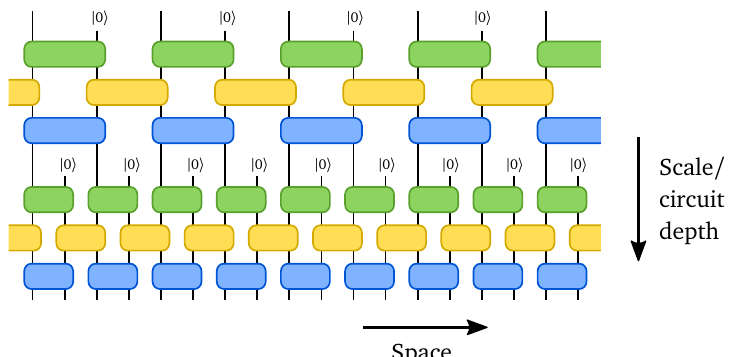
Figure 1: The structure of an entanglement renormalization circuit. Each layer is a constant depth quantum circuit that is supposed to implement a real-space renormalization. Every layer takes as input the output of the previous layer and a product state, resulting in an entangled quantum state at the bottom. Layers further up in the figure correspond to structure at larger